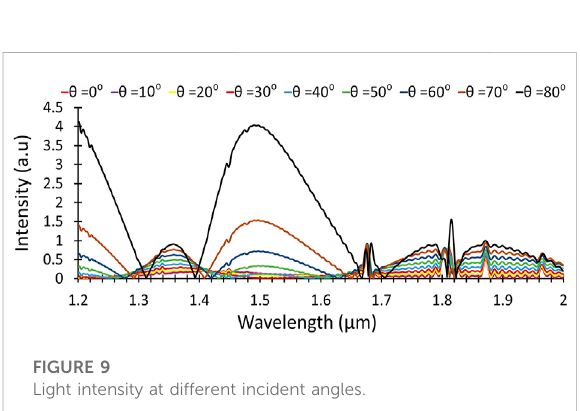
FIGURE 9 Light intensity at different incident